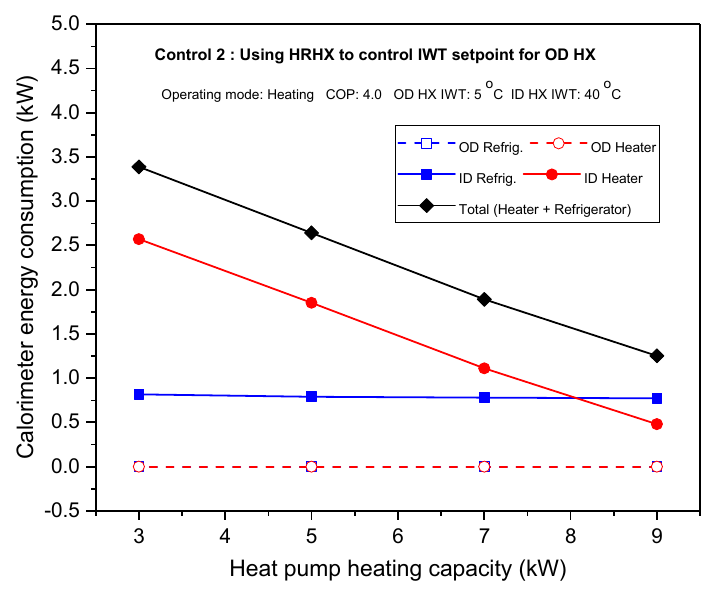
Figure 6. Calorimeter energy consumption with variation in heat pump heating capacity for control (2).